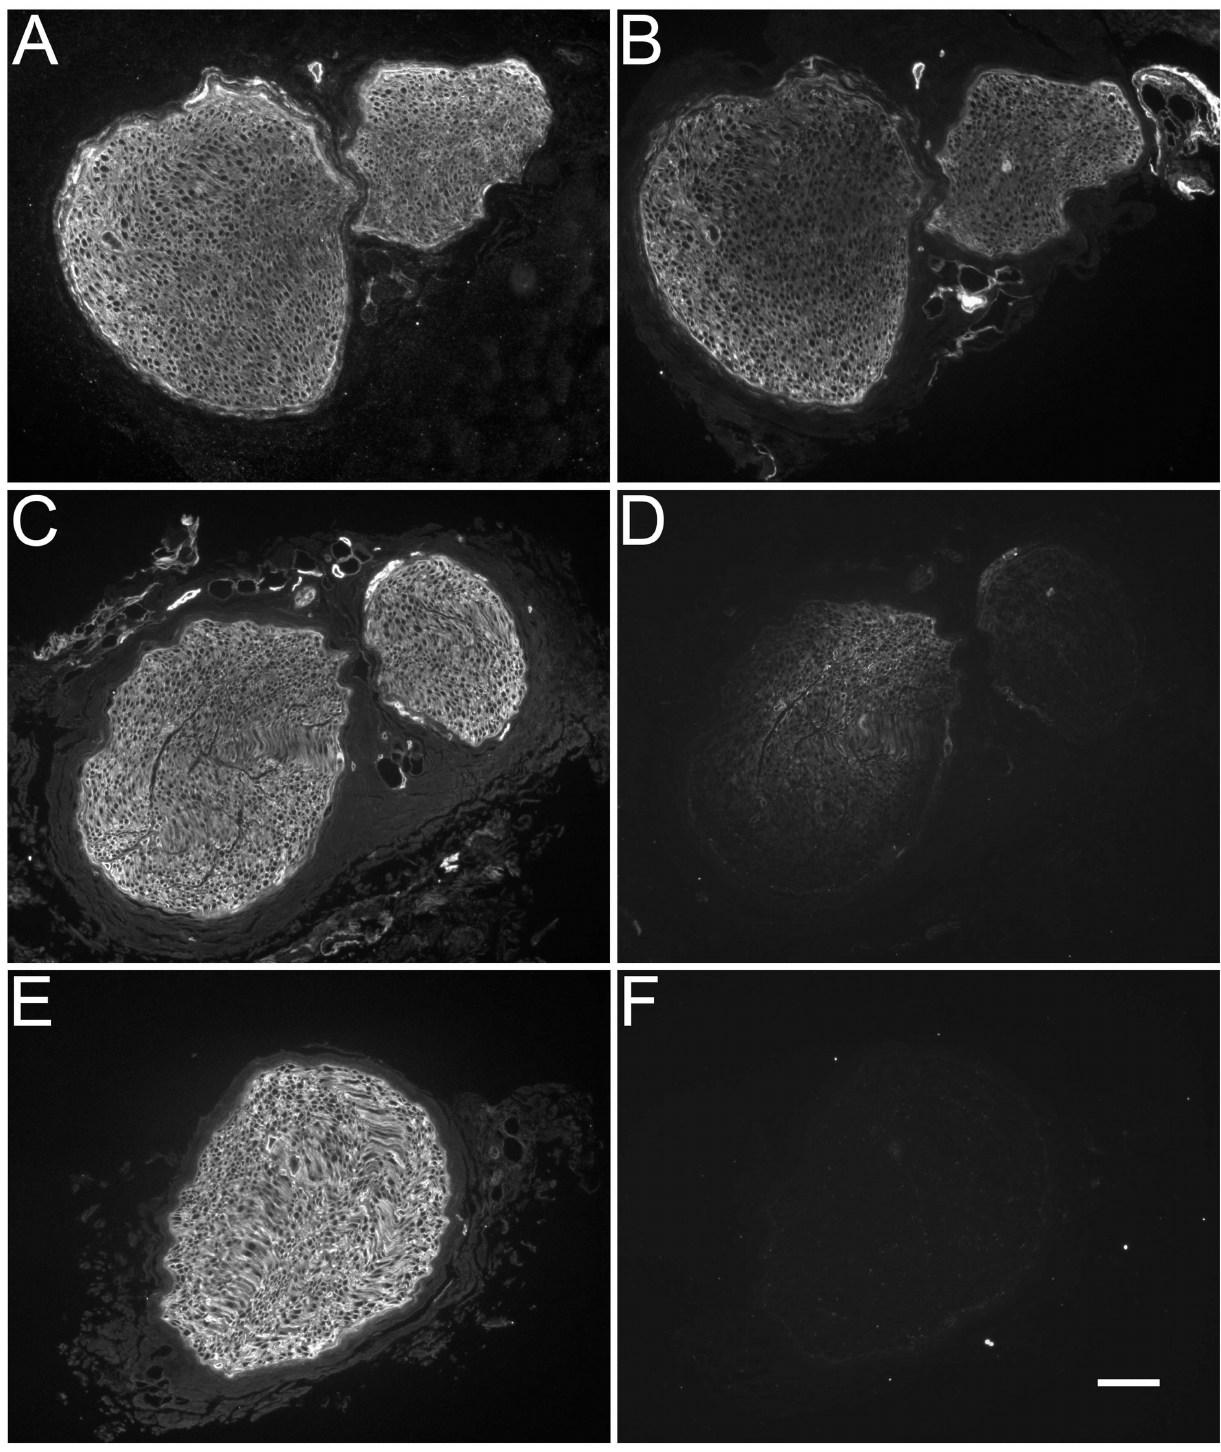
Fig 4. Optimum conditions for chondroitinase C treatment of nerve graft. Three-cm segmentsof rabbitperonealnerve were subjected to freeze/thaw treatment and incubated in various concentrations of chondroitinase C at different time durations(1U/ml 24hoursA and B; 4U/ml 16hoursC and D; 4U/ml 24hoursE and F). Sampleswere taken from the middleof the nerve segment andsubjectedto immunocytochemical analysisto determine whichconcentration/time durationrevealedthe C6S neoepitope (A, C, E) and completely removedthe CS-56 immunoreactive glycosaminoglycanchains(B, D, F). (A) 1U/ml for 24 hours revealed the C6S neoepitope throughoutthe endoneurial tissue. (B)